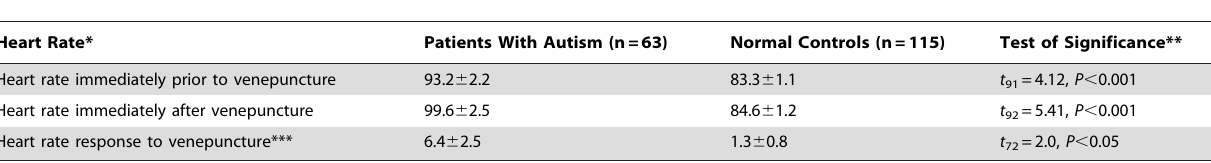
Heart Rate* Patients With Autism (n=63) Normal Controls (n=115) Test of Significance** Heart rate immediately prior to venepuncture